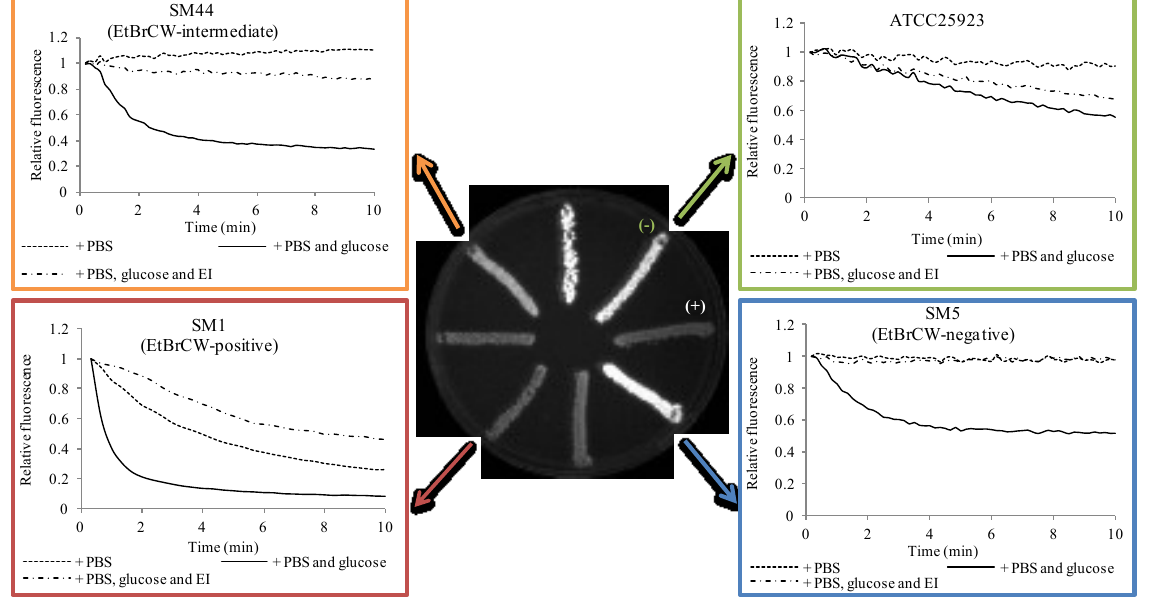
Figure 1. Characterization of reference and clinical isolates according to their efflux capacity. In green: reference strain S. aureus ATCC25923; in blue: EtBr-agar cartwheel (EtBrCW)-negative isolate SM5; in orange: EtBrCW-intermediate isolate SM44; in red: EtBrCW-positive isolate SM1. Central figure: screening of efflux activity by the EtBrCW method. Trypticase soy agar (TSA) plate supplemented with 2.5 mg/L EtBr streaked with representative isolates. (−) and (+): strains ATCC25923 and ATCC25923 respectively as negative and positive controls for EtBr efflux. Graphics: evaluation of efflux activity by real-time fluorometry. Efflux assays for representative isolates are shown for cells resuspended in Phosphate buffered saline (PBS), in PBS plus glucose (0.4%) or PBS plus glucose and the efflux inhibitor, verapamil (at the sub-inhibitory concentration of 200 mg/L). The data presented was normalized against the data obtained in conditions of no efflux (absence of glucose and presence of 200 mg/L of